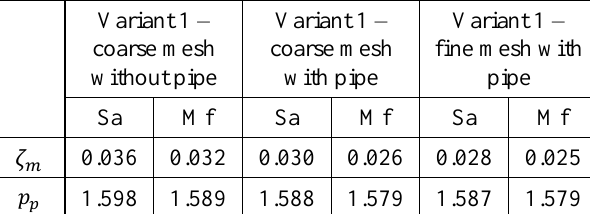
Table 3. Mesh comparison – Variant 1 (0.2 𝑀𝑎